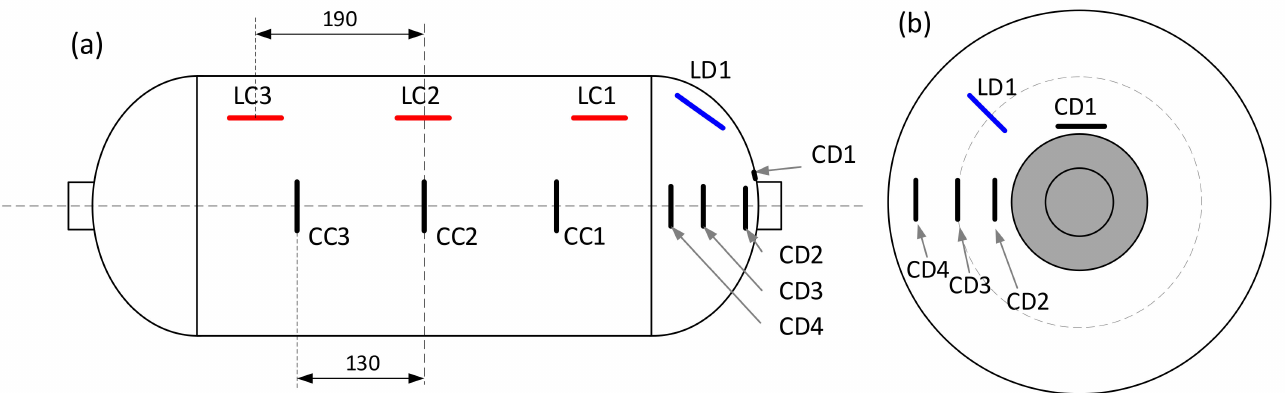
Figure 7. Placement of sensors on the liner. ( a ) Entire liner and ( b ) dome part. Colors are attributed to the different directions and locations of sensors: black—circumferential, red—longitudinal at the cylindrical part, blue—longitudinal at the